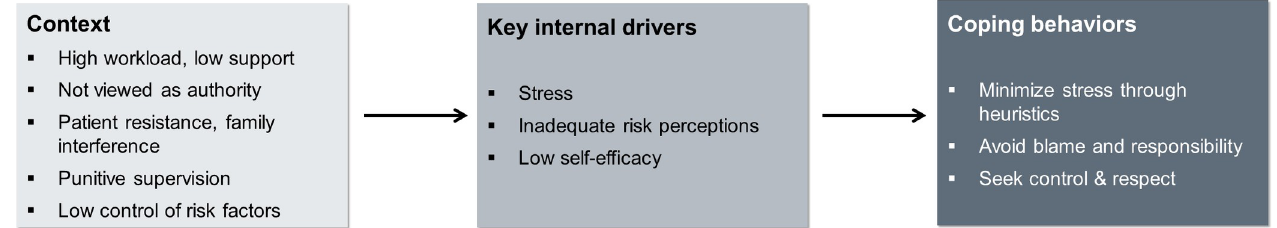
Fig 6. Contextual influences on staff nurse drivers of behavior and associated coping behaviors, as distilled from immersions and responses to decision- making game scenarios.